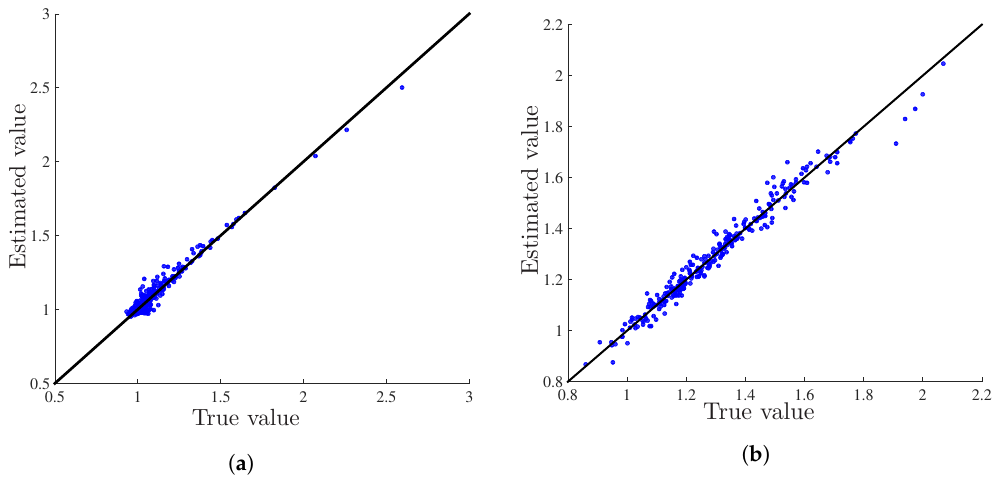
Figure 7. ( a ) Comparison of the KKF estimate (ˆ u t ) with the true value ( u t ) (Figure 4) with the measurements from the selected locations shown in Figure 6a; ( b ) Comparison of the KKF estimate (ˆ u t ) with the true value ( u t ) (Figure 5) with the measurements from the selected locations shown in Figure